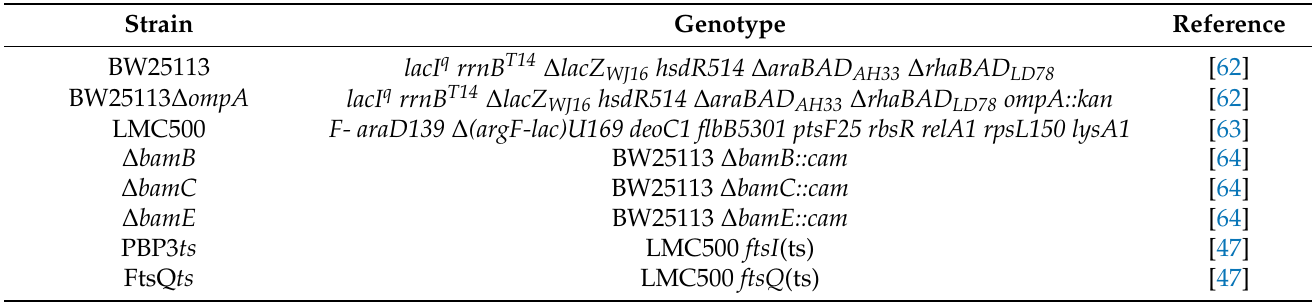
Table 1. Strains and genotypes used in this